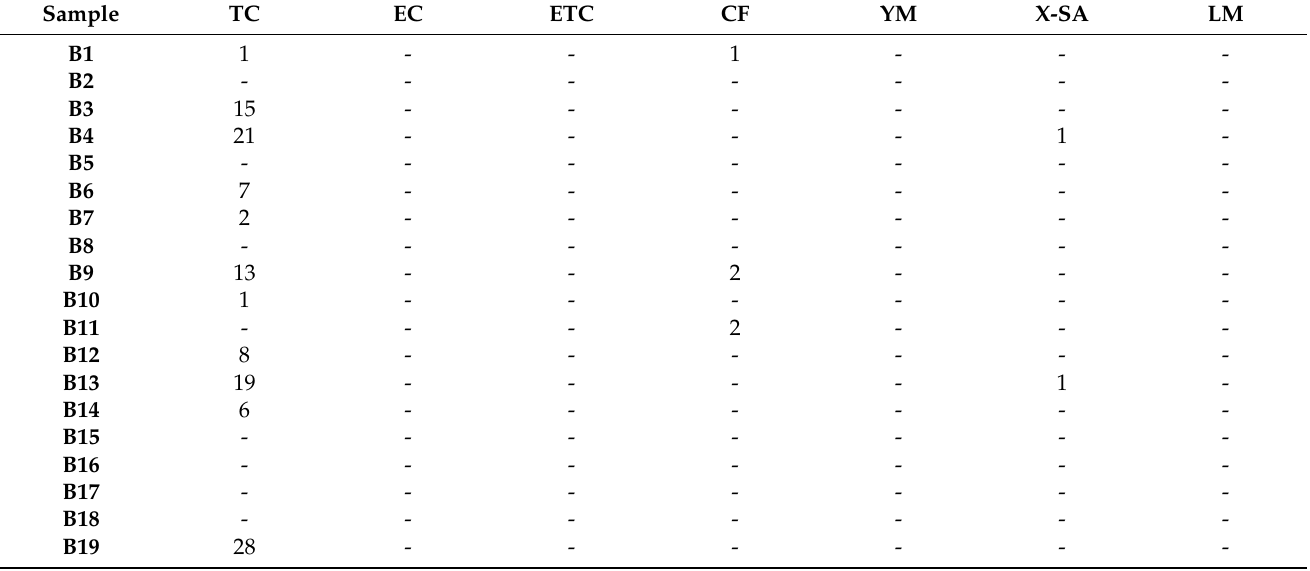
Table 5. Microbiological assessment (ufc/g) of films developed with essential oils incorporated for relevant microorganism categories and species.